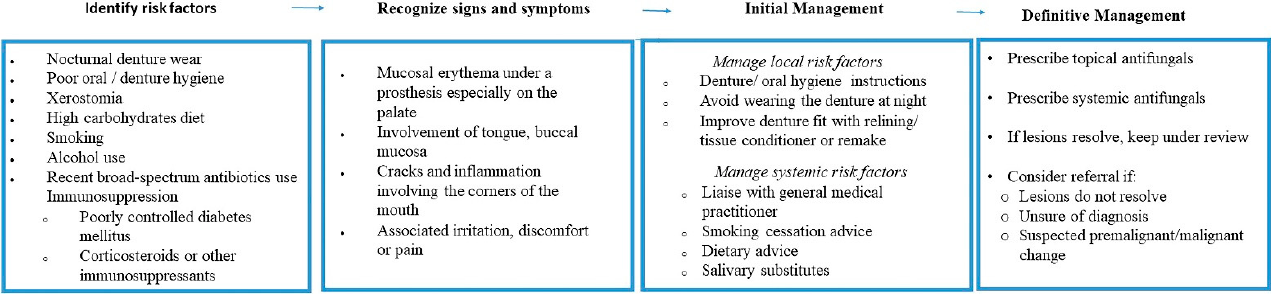
Figure 6. A schematic management of DS.